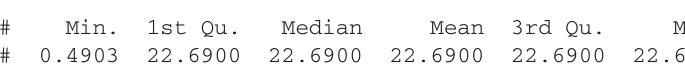
The extent of shrinkage is determined by the prior degrees of freedom (d.f.). Large prior d.f. indicates that the disper- sions were similar across windows, such that strong shrinkage to the trend could be performed to increase stability and power. Small prior d.f. indicates that the dispersions were more variable. In such cases, less squeezing is performed as strong shrinkage would be inappropriate. Also note the use of robust=TRUE , which reduces the sensitivity of the EB procedures to outlier